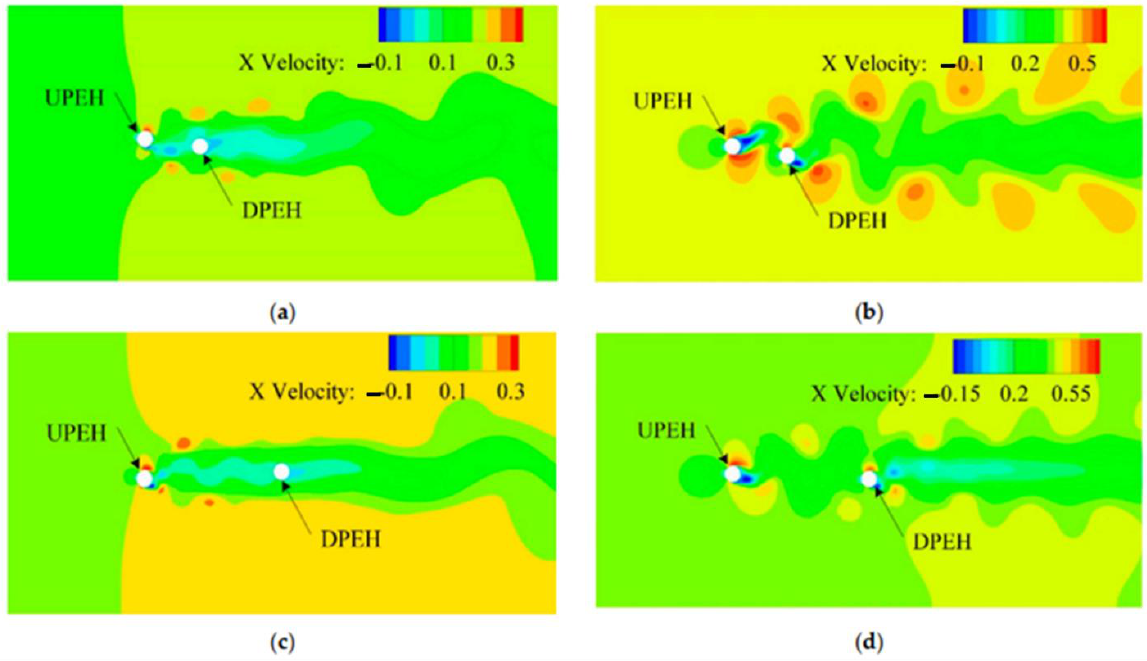
Figure 11. Duplet tandem PEH flow field scattering for different W/D and water velocity: ( a ) dispersion of the flow field at W/D = 3.33, U = 0.19 m/s; ( b ) flow-field dispersal at W/D = 3.33, U = 0.41 m/s; ( c ) flow-field dispersal at W/D = 3.33, U = 0.19 m/s; ( d ) flow-field dispersal at W/D = 8.33, U = 0.41 m/s [198].